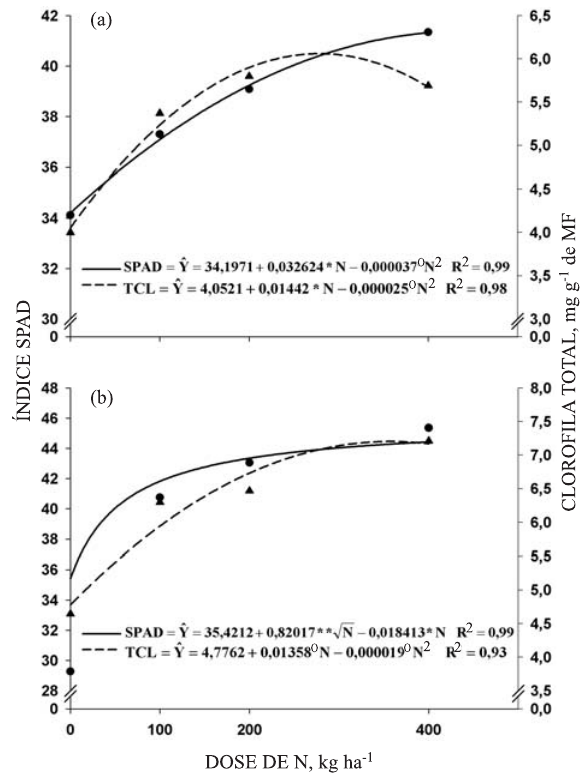
Figura 3. Índice SPAD e teor de clorofila medido na quarta folha a partir do ápice da batateira aos 21 DAE para as cultivares Ágata (a) e Asterix (b), em função das doses de nitrogênio. **, * e °: significativo a 1, 5 e 10 %, respectivamente, pelo teste